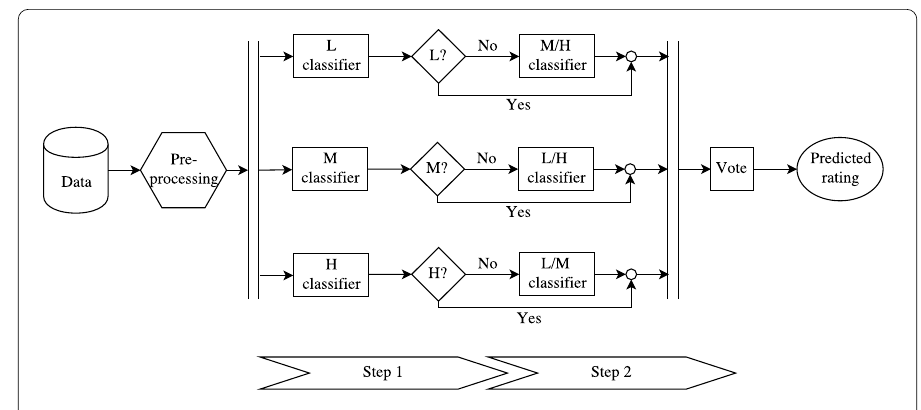
Figure 5 Schematic representation of the 2-steps classifier